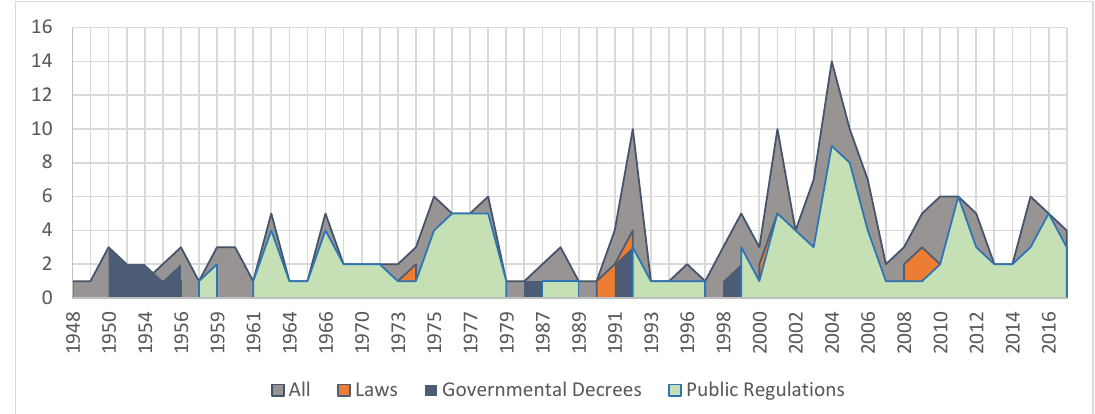
Fig. 2. Legislative acts about water protection in Czech Republic 1948-2019